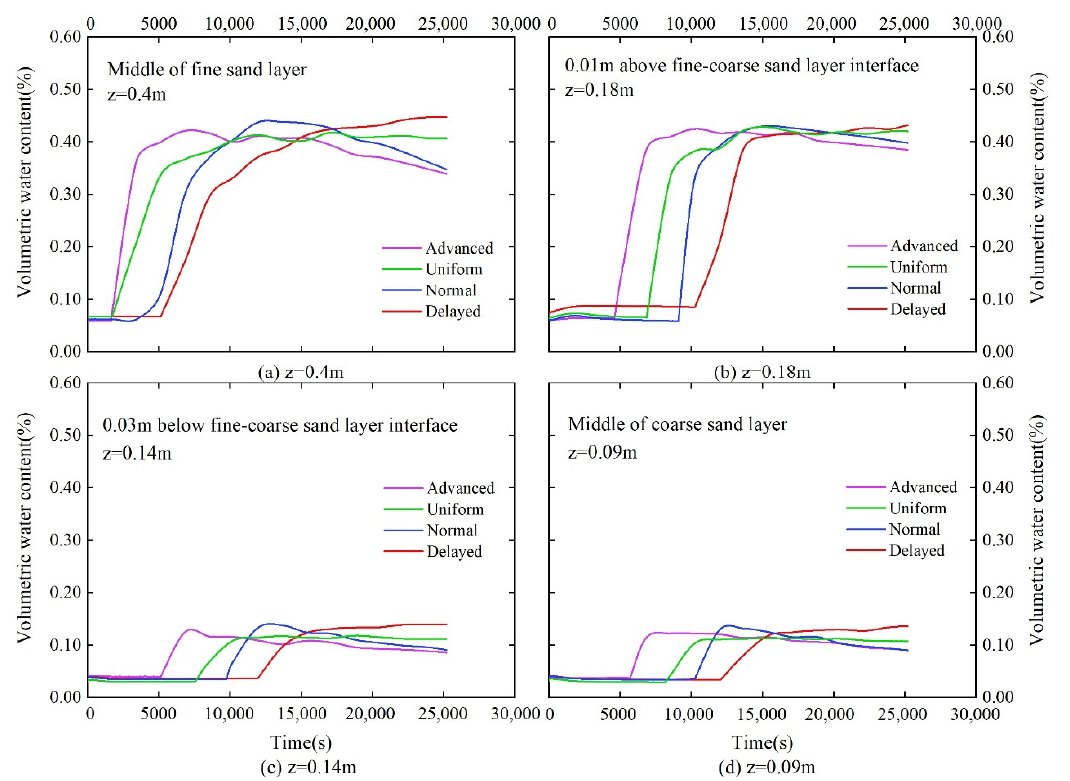
Figure 10. Variations of volumetric water content with time at ( a ) z = 0.4 m, ( b ) z = 0.18 m, ( c ) z = 0.14 m and ( d ) z = 0.09 m under relatively long rainfall